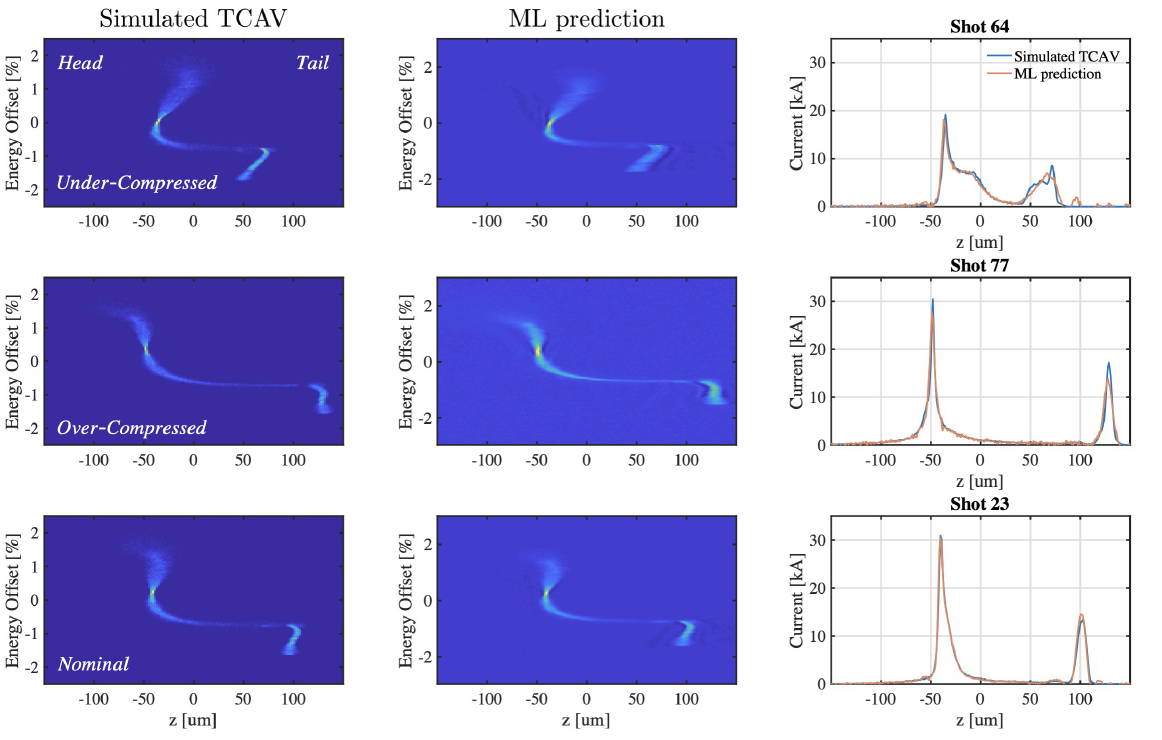
Figure 2. Example shots from numerical simulation of the FACET-II two-bunch operation mode with nominal jitter values that are given in Table 1. The beam parameters are 2 nC charge and 10 GeV energy. The ML model accurately predicts the LPS distribution including chirp, time separation and bunch charge ratio. The current profile matches well with what is measured on the Transverse Deflecting Cavity (TCAV). This may deviate from the true current profile at the interaction point (IP) due to resolution limits of the TCAV for some high current shots, as shown in Figure